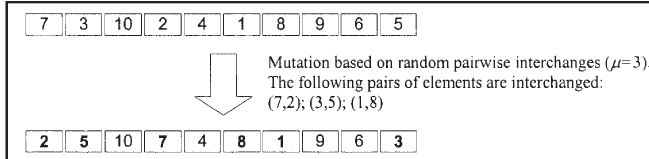
Figure 10. Pseudo-code of the random interchanges based mutation.